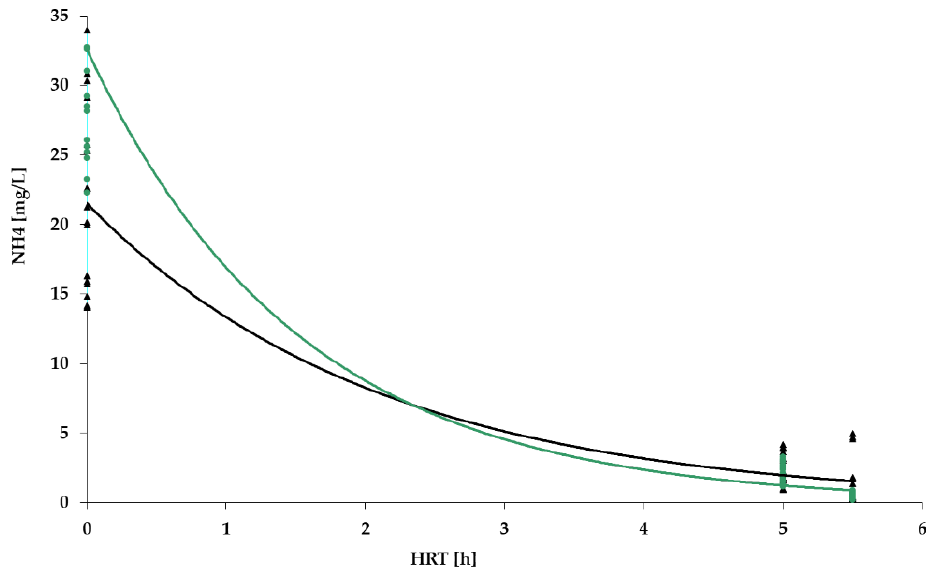
Figure 16. NO 2 dynamics for PV floating carrier: stage 1 (black); stage 2 (green).